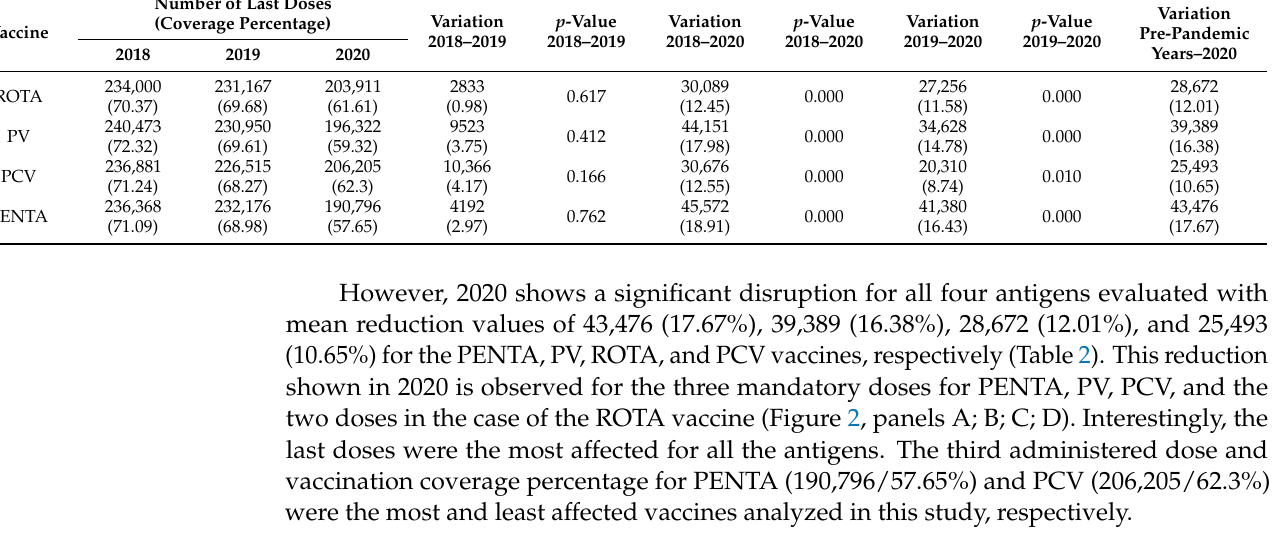
Table 2. Variation of last administered vaccination doses and coverage percentage for infants in Ecuador. Number of Last Doses (Coverage Percentage) Vaccine